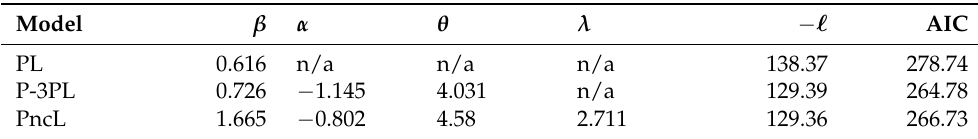
Table 4. Estimated parameters and goodness of fit statistics of considered discrete models for the psychiatric dataset.